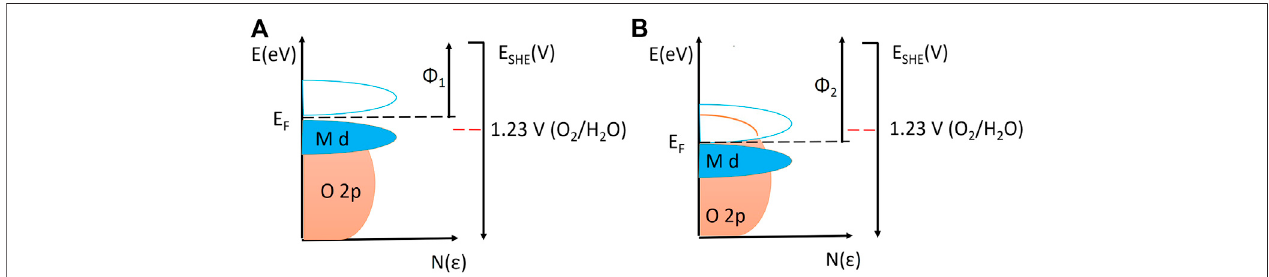
FIGURE5| Densityofstatesandrelativepositionsofdband,O2pband,Fermilevel,andworkfunctionsonthevacuumscale,inrelationtoOERreversiblepotential on the standard hydrogen redox potential scale. (A) Oxide with low work function and Fermi level positioned above OER reversible redox potential. (B) Oxide with high work function and Fermi level positioned below OER reversible redox potential and inside O2p band, allowing OER from the lattice. Replotted using information from (Hong et al., 2015).